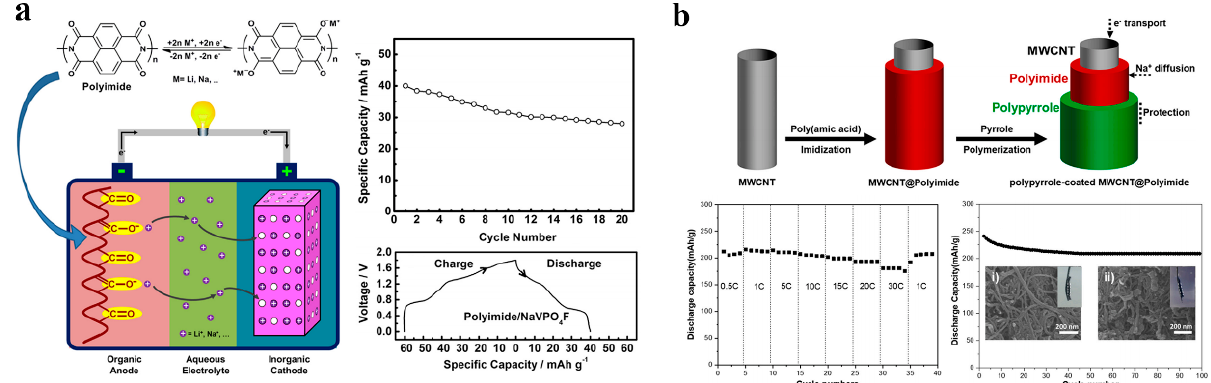
Figure 9. ( a ) The configuration with cycling profiles and first cycle charge/discharge curves of the full cell. Reproduced with the permission of ref. [31], copyright 2013 Elsevier B.V. ( b ) The illustration of the synthesis and electrochemical performance. Reproduced with the permission of ref. [89], cop- yright 2020 Elsevier B.V.